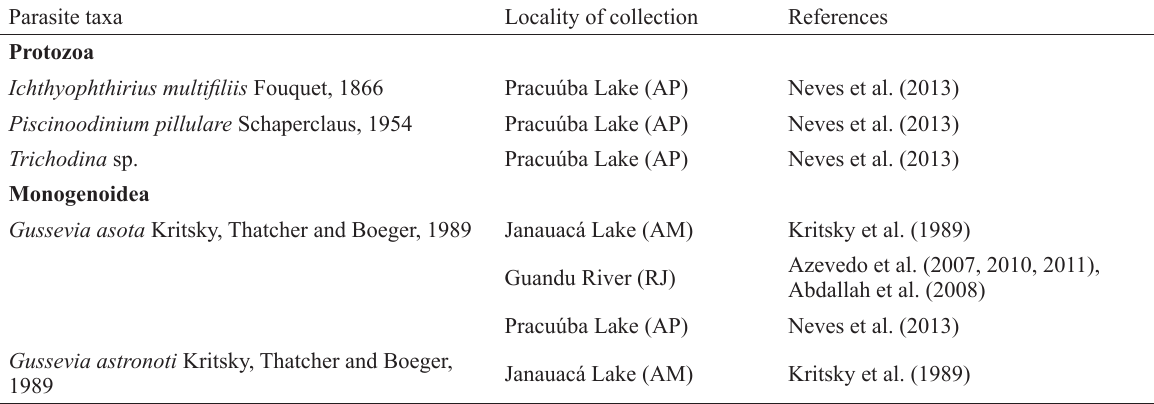
List of parasites in Astronotus ocellatus from different hydrographic basis in Brazil. Parasite